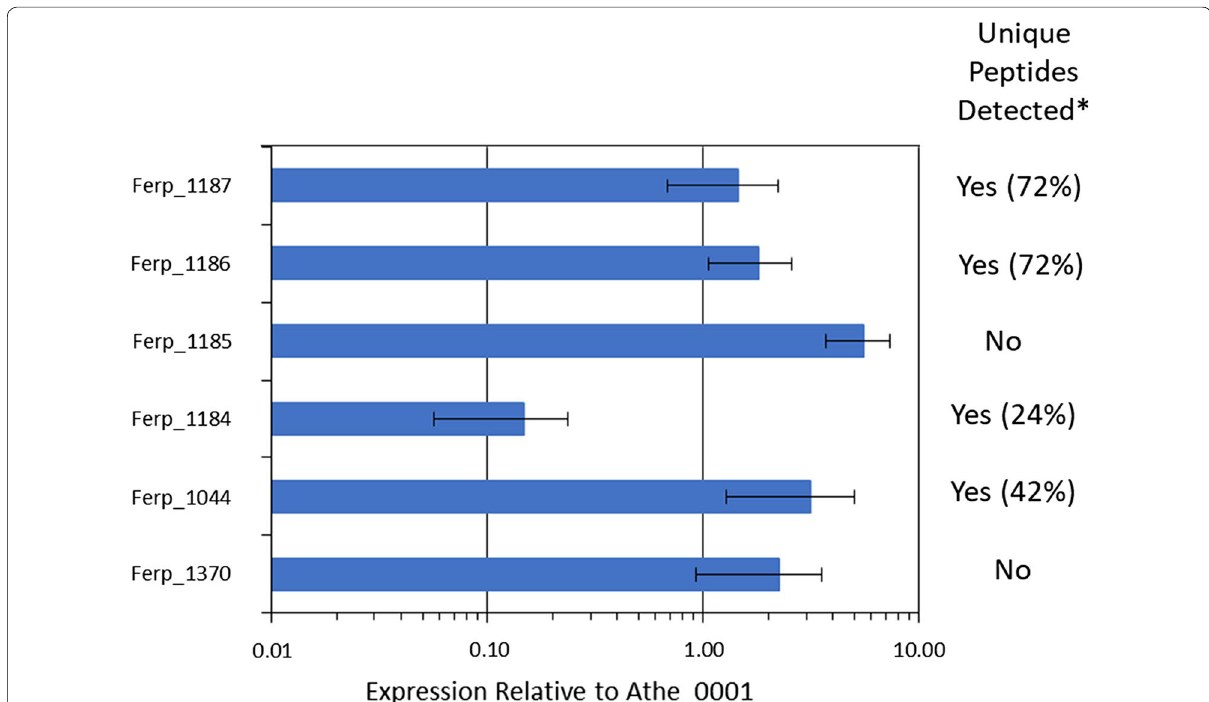
Fig. 3 Relative expression of heterologously expressed benzoate catabolism genes in strain JWCB018 pJOT2 measured by RT-qPCR. Relative expression was calculated with respect to dnaA , a constitutively expressed chromosomal replication initiation protein (Athe_0001). Though all genes appeared to be transcribed, unique peptides were not identified for two proteins: Ferp_1370 (a putative benzoate transporter) and Ferp_1185 (one of four subunits of benzoyl-CoA reductase). *Heterologously expressed Ferroglobus placidus proteins were deemed present if normalized protein abundance was significantly ( p value < 0.02, n 3, log2 fold change > 1) greater in strain JWCB018 pJOT2 than in strain JWCB018 = pJGW07. Numbers in parenthesis indicate percentages of each gene’s coding sequence represented by unique peptides identified through intracellular proteomics